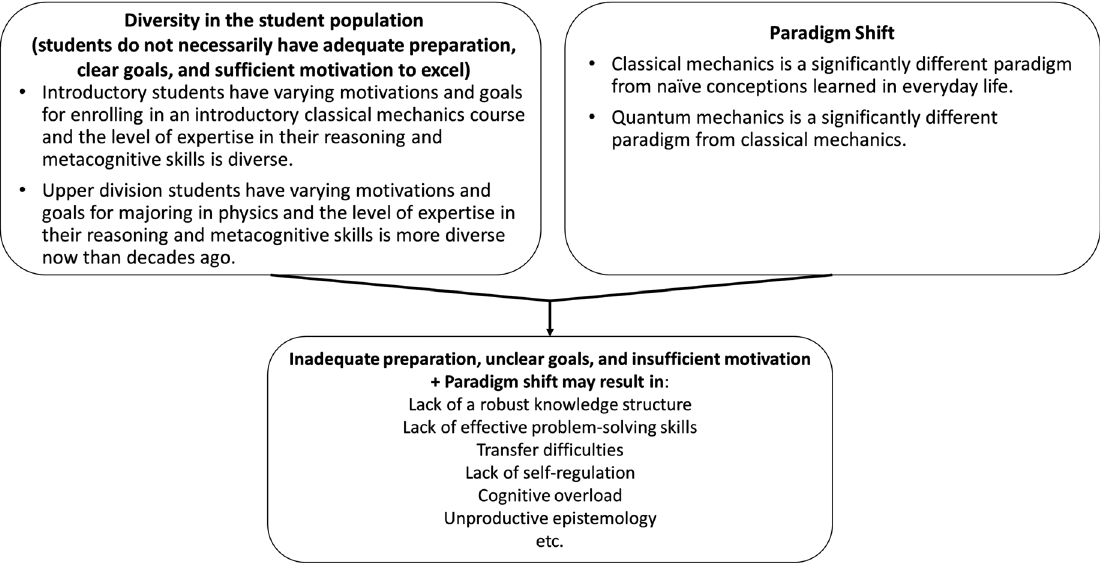
FIG. 1. Framework for understanding why patterns of difficulties in quantum mechanics are analogous to those in introductory classical